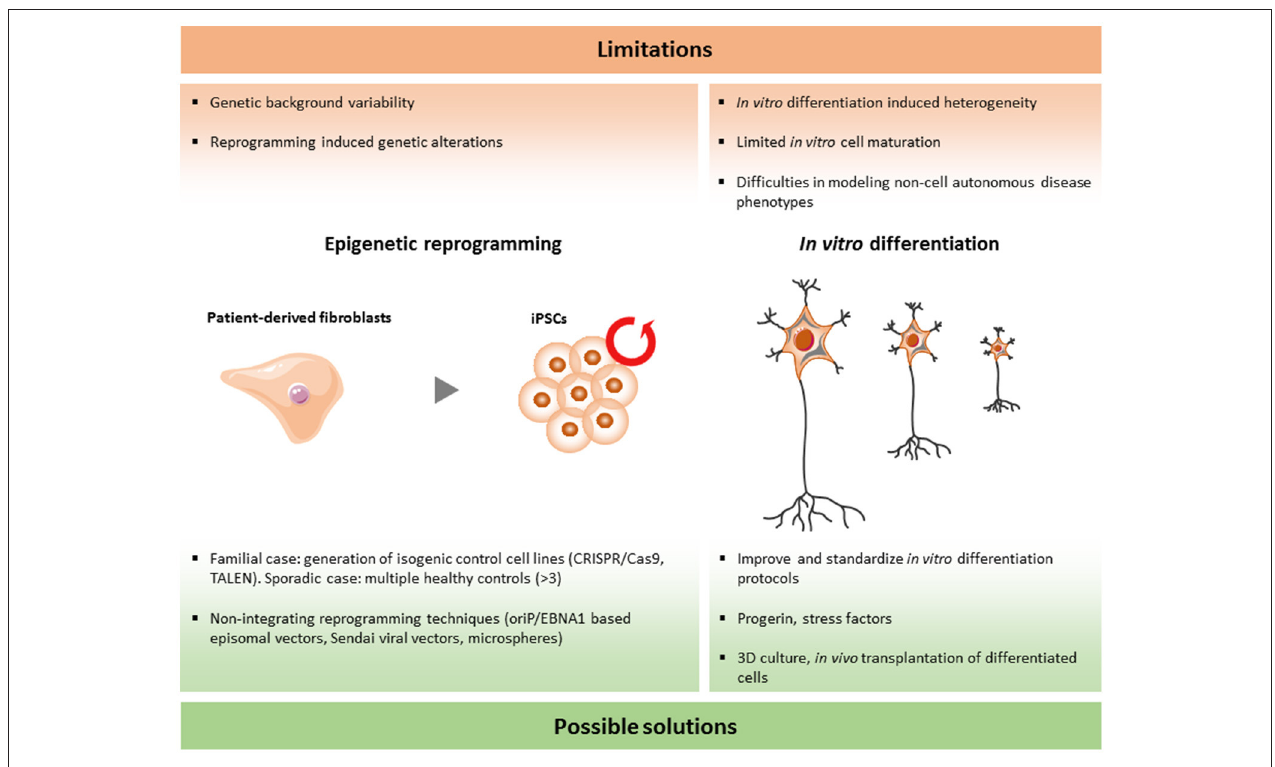
FIGURE 2 | Limitations and current solutions to iPSC technology in